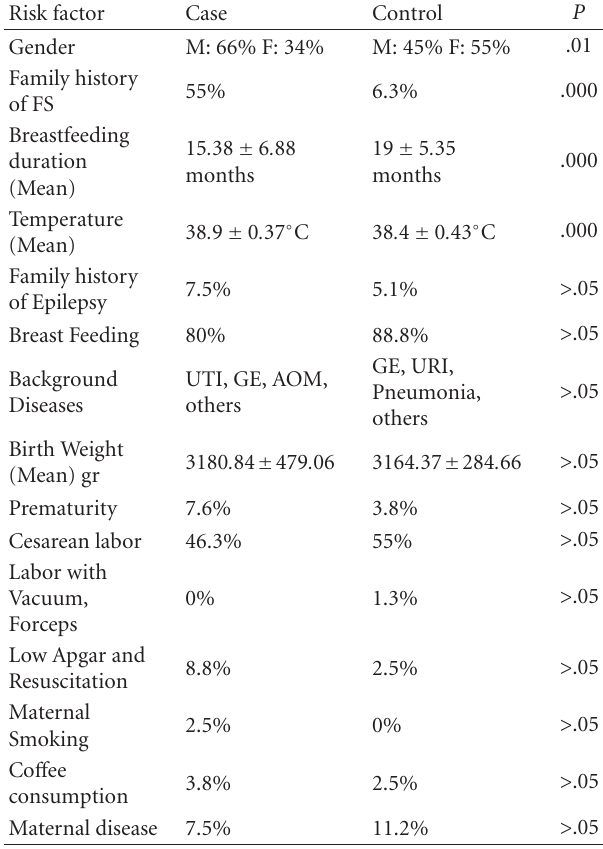
Table 1: Comparison of Risk Factors among children with first febrile Seizures (case group) and healthy children (control group) in Qazvin,